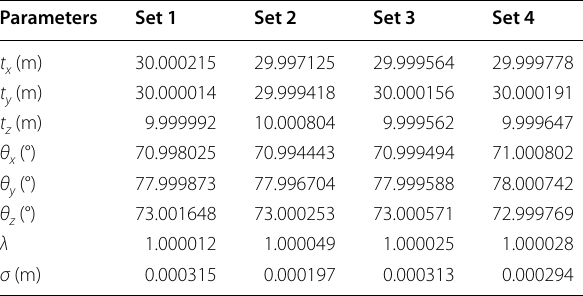
Table 12 Computed transformation parameters for Set 1 to Set 4 by ADQA, MPA, and